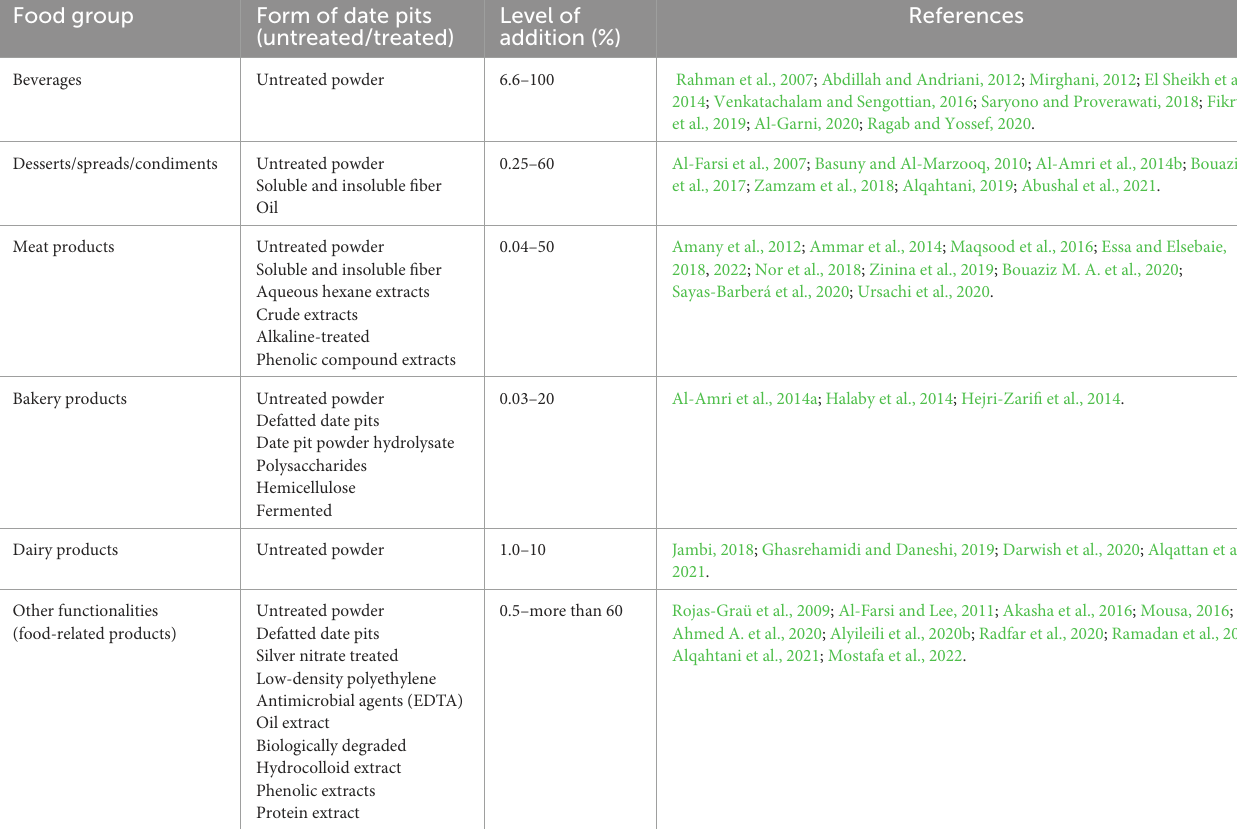
TABLE 2 Ratios at which date pits can be incorporated into various types of food